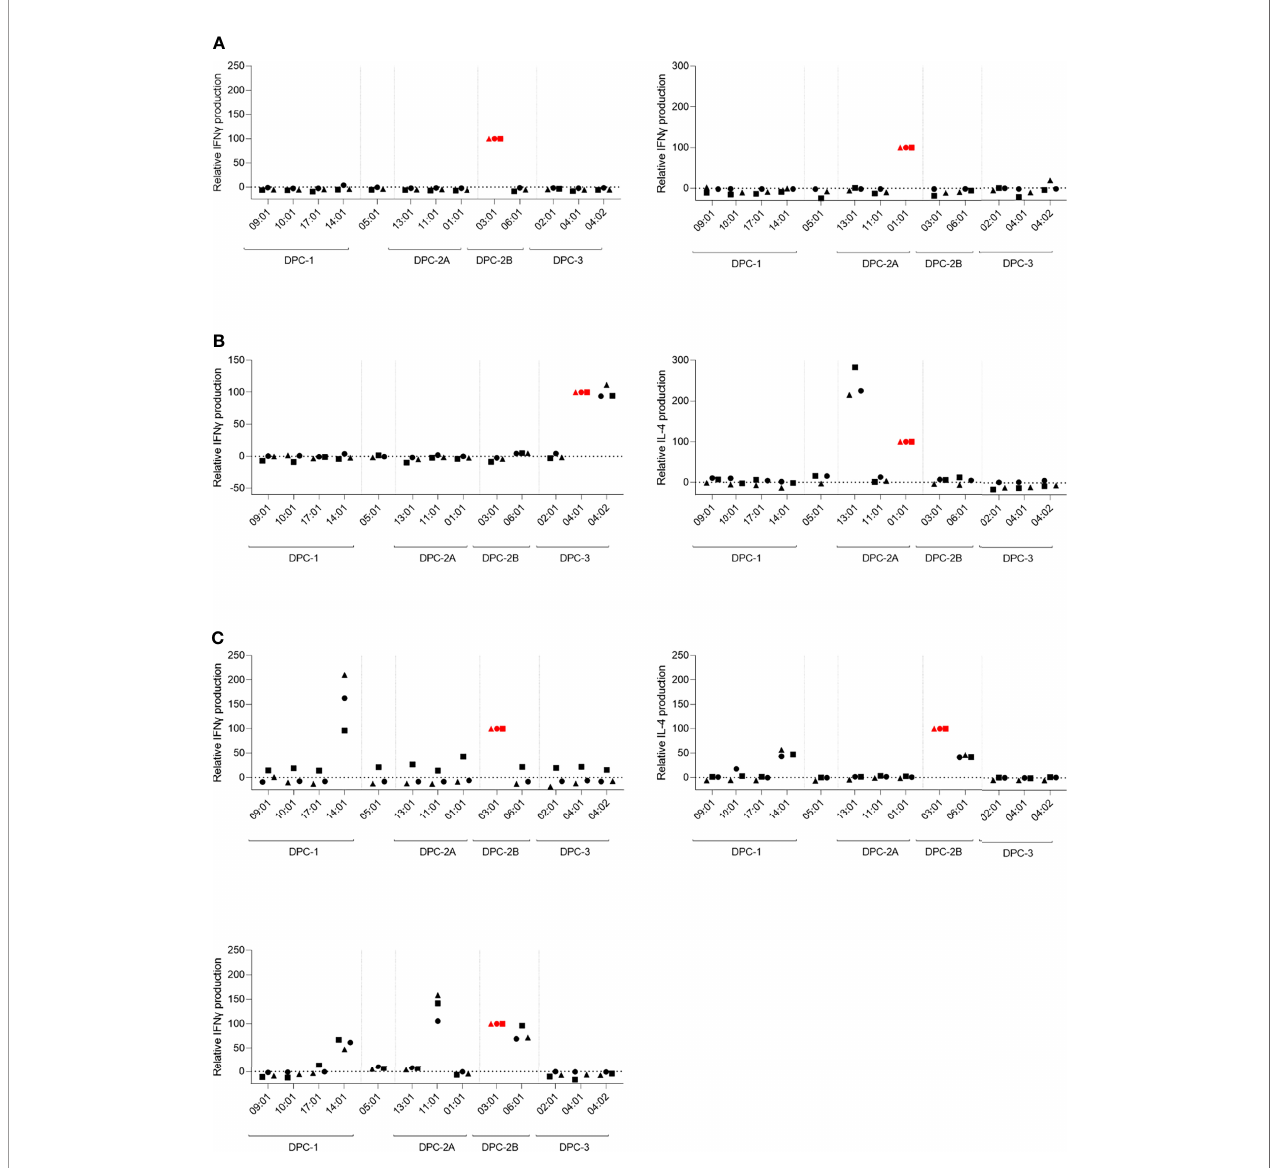
FIGURE 3 | T-cell clones exerting cross-reactivity against HLA-DP molecules from the same or different DPC groups. The relative reactivity of allo-HLA-DP-directed CD4 T-cell clones after overnight stimulation with the panel of HLA-DP-transduced K562 cell lines. The concentration of IFN g or IL-4 was measured in the supernatants using ELISA. The levels of cytokine production upon cross-reactivity were normalized for the level of cytokine production upon stimulation with the K562 expressing the respective target HLA-DP molecule. (A) CD4 T-cell clones with reactivity against single target HLA-DP molecule. (B) CD4 T-cell clones with reactivity against the target HLA-DP molecule and cross-reactivity against another HLA-DP molecule within the same DPC group. (C) CD4 T-cell clones with cross-reactivity against multiple HLA-DP molecules within the same DPC group as the target HLA-DP molecule, as well as against HLA-DP molecules from another DPC group. The red colored symbols are the measurements after stimulation with the K562 expressing the target HLA-DP molecule. Each symbol represents one